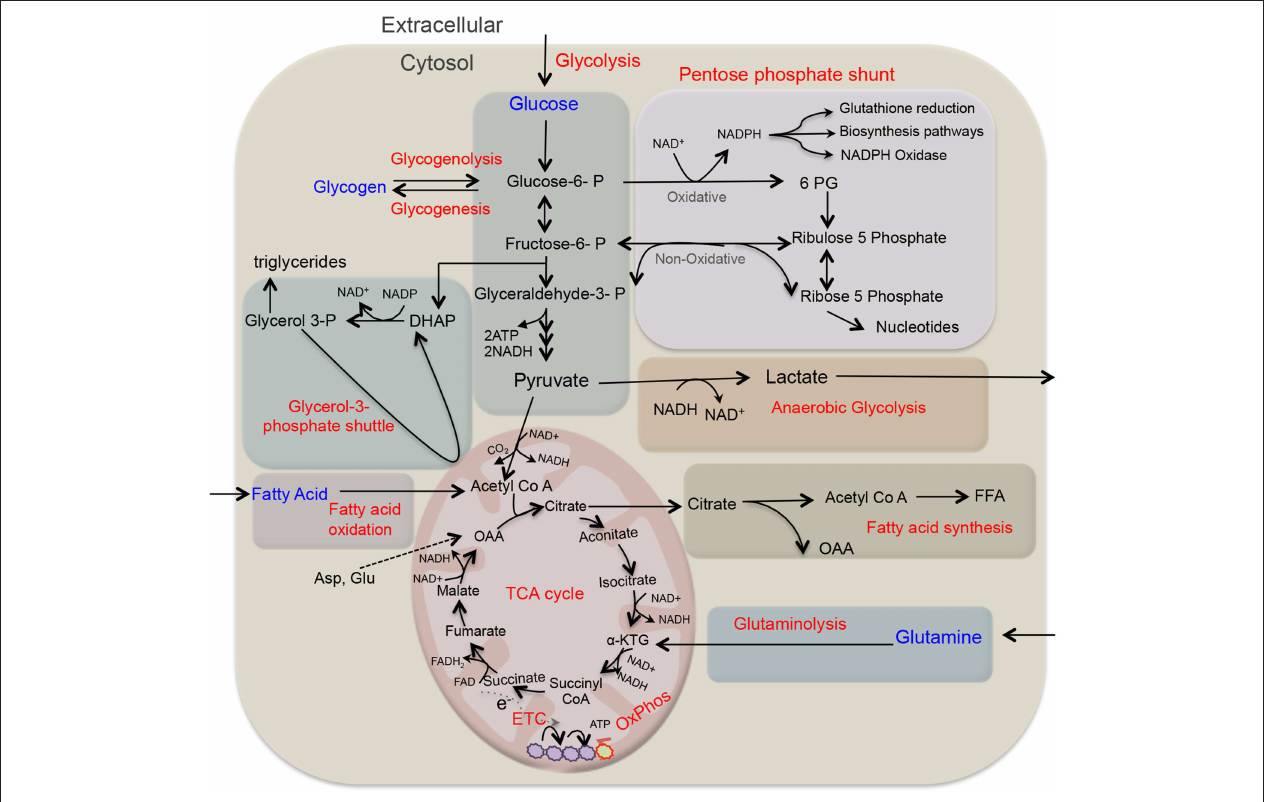
FIGURE 1 | Overview of key metabolic pathways in neutrophils. Glycolysis is a major metabolic pathway in neutrophil cytosol, which converts glucose to pyruvate through a series of enzymes and reaction. In the absence of oxygen through anaerobic glycolysis, pyruvate gets reduce to lactate, and secreted out. While in the presence of oxygen, pyruvate participates in TCA cycle by its conversion to acetyl-coenzyme A (acetyl Co A) that provides reducing energy intermediates NADH and FADH2 which trough ETC generate ATPs. Neutrophils also utilize additional pentose-phosphate pathway (PPP) by using glucose-6-phosphate, an intermediate of the glycolytic pathway, as an entry point and using oxidative and non-oxidative phases produce NADPH and riboses that subsequently generate nucleotides. NADPH is critical as key NADPH oxidase dependent ROS generation in neutrophils and also regulates redox signaling. Depending on glucose abundance, glycogen stores get enriched in neutrophils that on-demand provides glucose based glycolytic intermediate supply. TCA cycle intermediate citrate through fatty acid synthesis (FAS) can lead to the generation of free fatty acid, while these endogenous FFA or transported from the extracellular environment through FAO pathway yields acetyl-CoA that fuels TCA cycle and produce significantly more energy in form of ATPs. Glutamine through glutaminolysis produces α -ketoglutarate and thus supports the TCA cycle. In addition, neutrophils also utilize glycerol-3- phosphate shuttle to generate NAD + from NADH and helps in maintaining mitochondrial membrane potential.